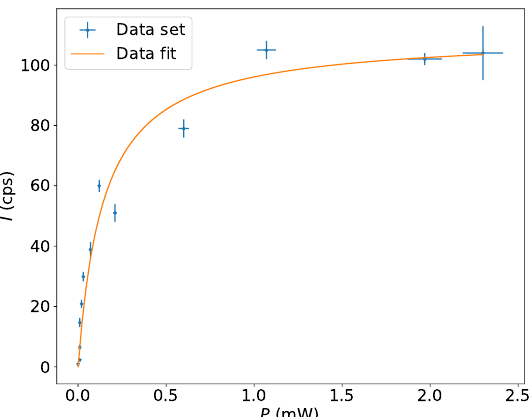
Figure 8. Measured count rate I as a function of excitation step power P for the RIS scheme presented in Figure 7. The orange curve represents a fit to the measured data.